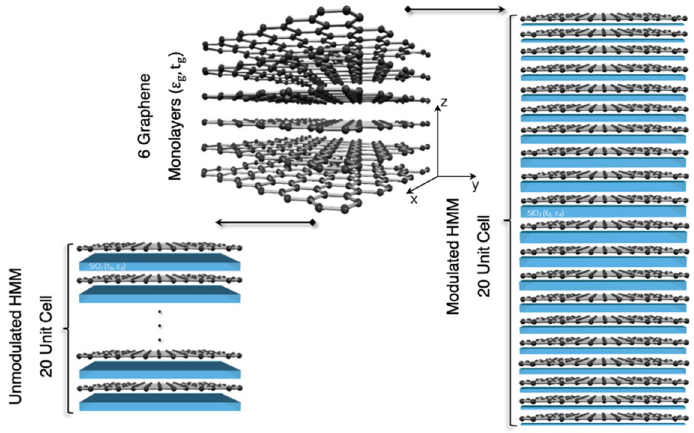
Figure 1. 3D scheme for both the unmodulated and modulated composite